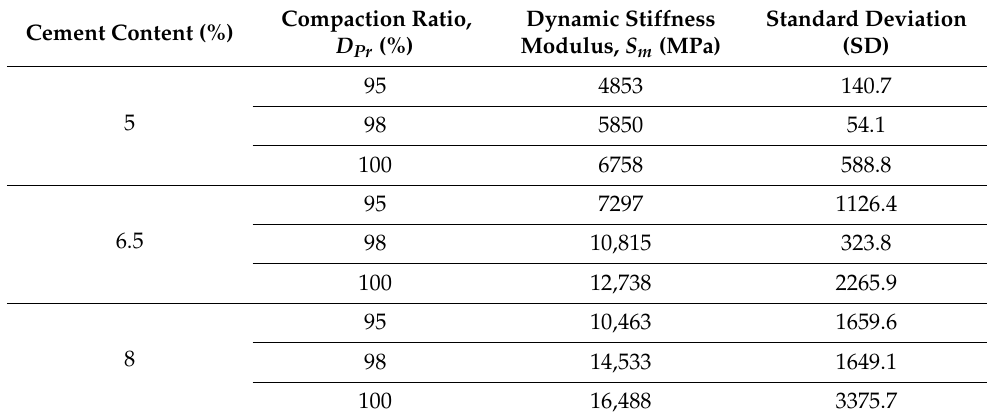
Table 5. Test results: dynamic stiffness modulus under different compaction ratios, D Pr , and cement dosages.